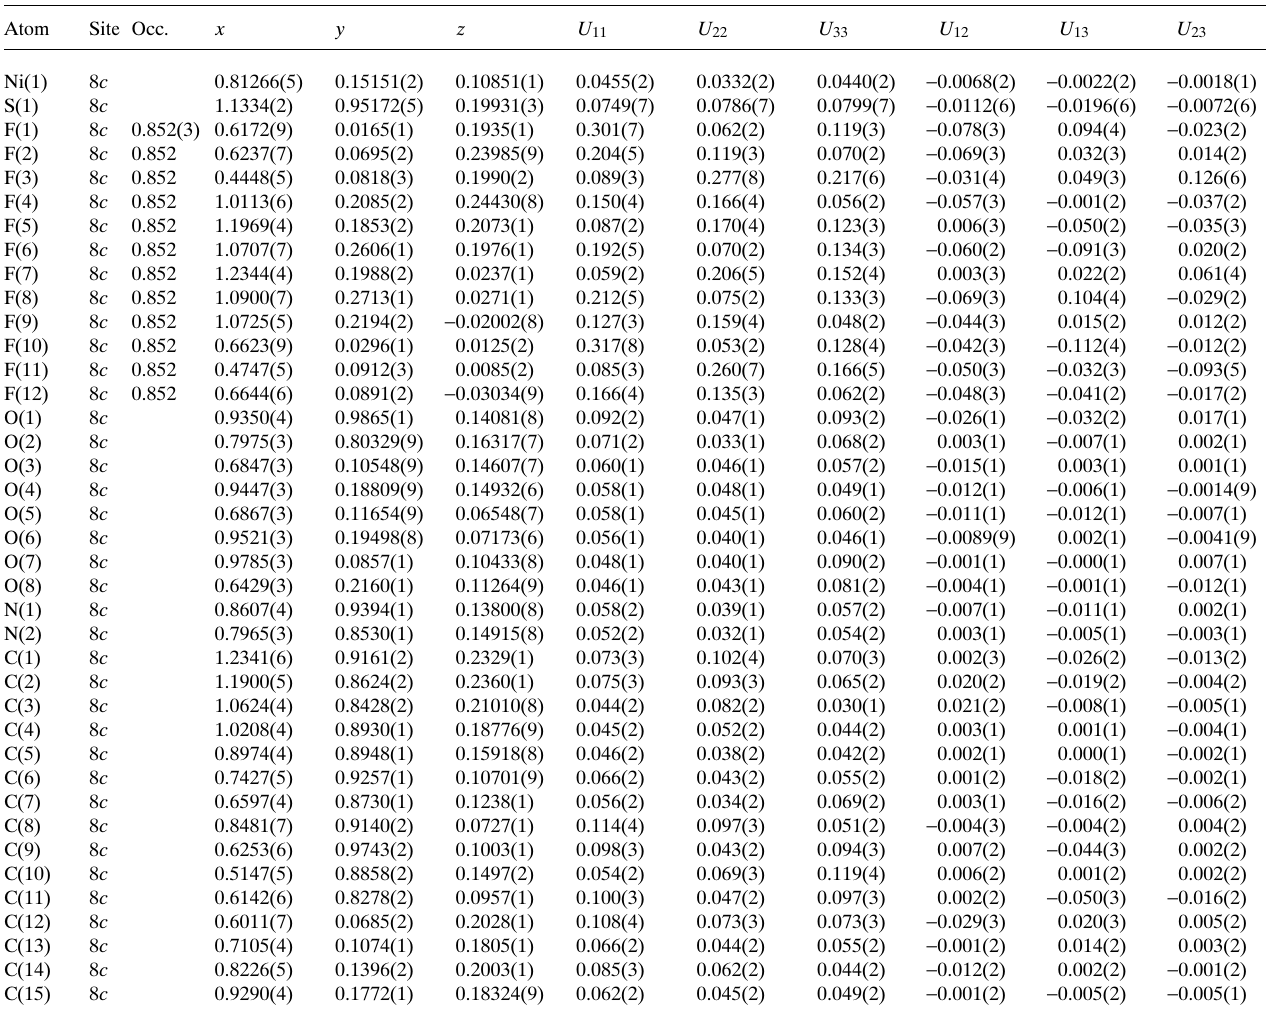
Table 3. Atomic coordinates and displacement parameters (in Å 2 ) .